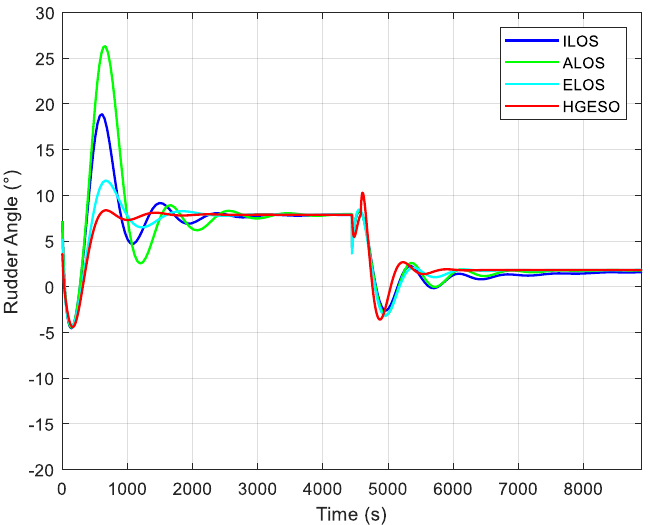
Figure 11. Comparison of rudder angle with different guidance laws at varying desired paths.